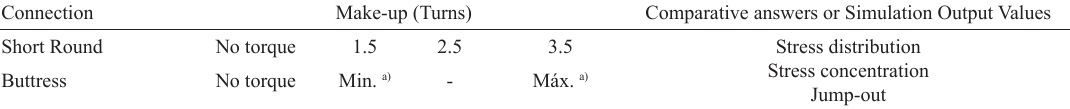
Table 3: Make-up torque evaluated in the API connections.